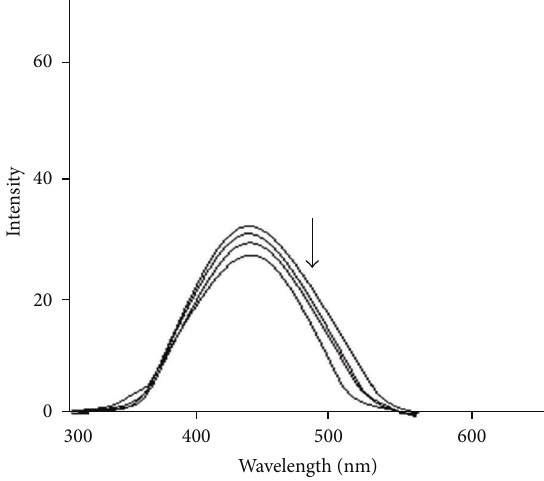
Figure 6: Fluorescence spectra of DNA-EB (10mM) in the presence of 0, 15, 25, and 35 mM of complex 3. Arrow shows the changes in the emission intensity as a function of complex